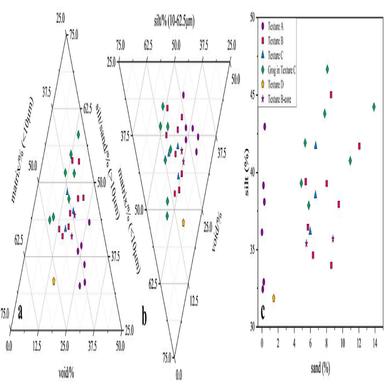
Quantitative comparison of the components of four mould textures and one core texture. a): Ternary diagram; b): Ternary diagram after subtracting the sand particles(>62.5 μm) and re-normalization; c): Binary plot of the content of silt against sand.